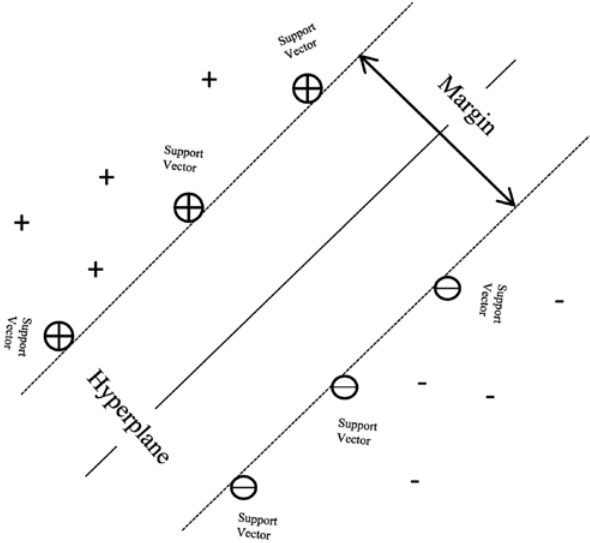
Figure 3: Support Vector